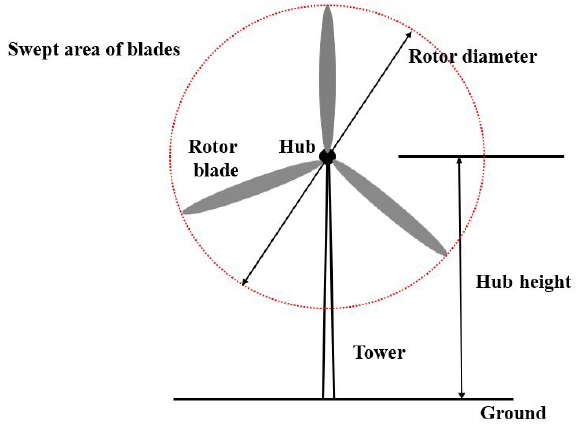
Figure 1. Schematic of the typical utility-scale, three-blade, hori- zontal axis wind